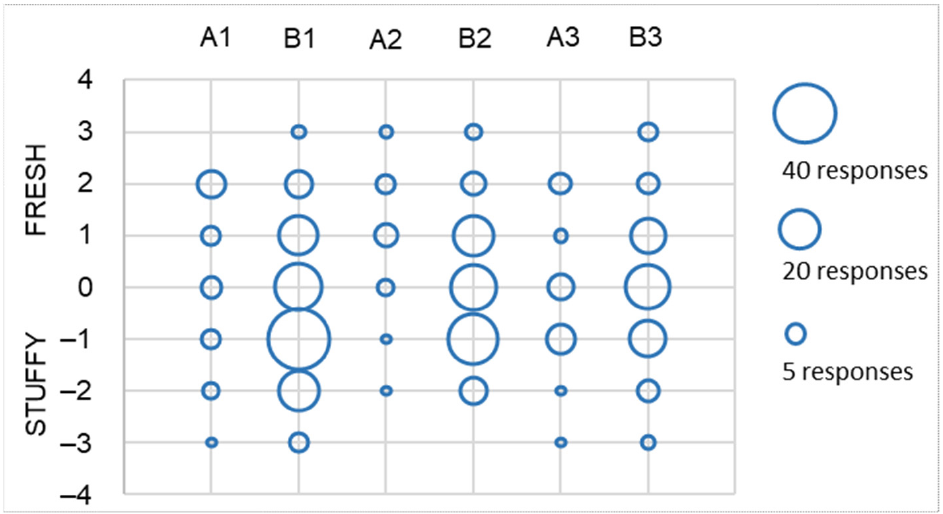
Figure 7. The distribution of students’ responses about indoor air quality (fresh/stuffy air) for all groups during the three measurements days (AfSV).